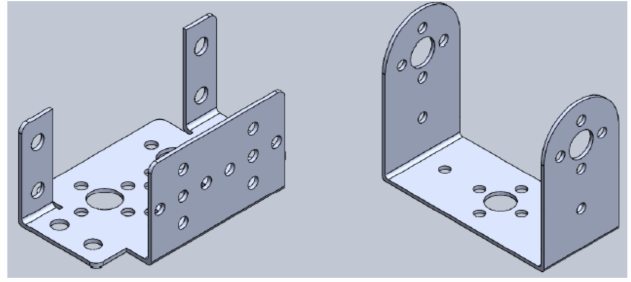
Figure 8. Servo Brackets for tilt-pan mechanism.